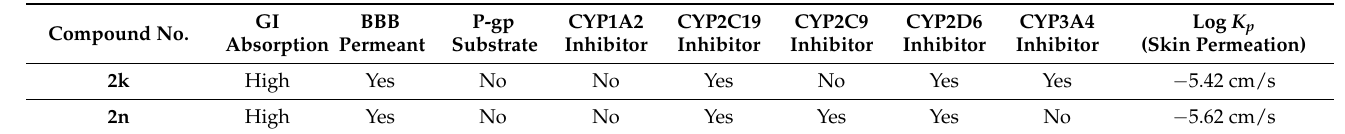
Figure 9. The putative 3D binding mode of 2k with MAO-B. The π - π binding interactions are indicated by green thick dash lines with the distance between two centroids of the rings, and the hydrogen bonds are depicted by blue thick dash lines with the distance between donor and acceptor atoms. The detailed analyses including donor and acceptor atoms and the distance are tabulated on right of the Figure. Table 4. Predicted pharmacokinetic properties of 2k and 2n .